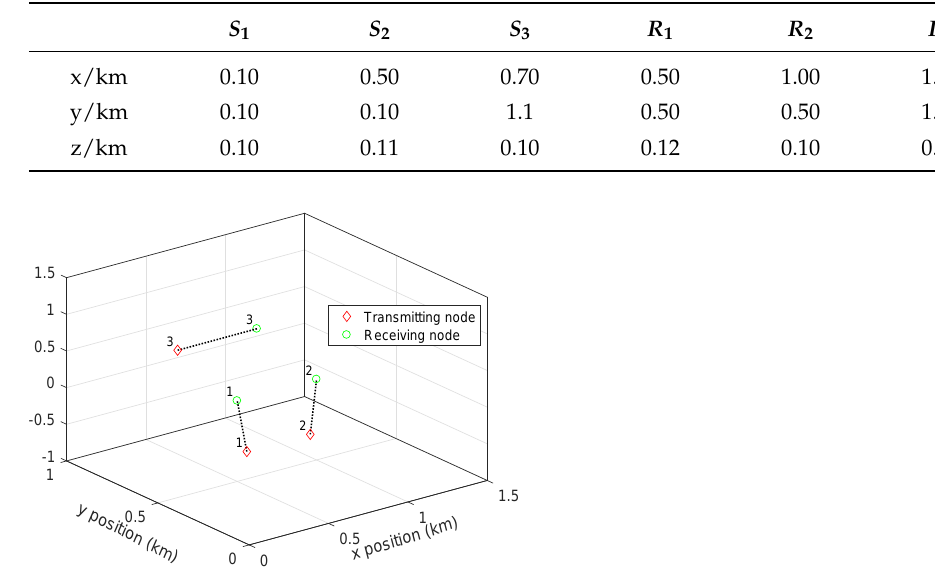
Figure 2. Distribution of communication